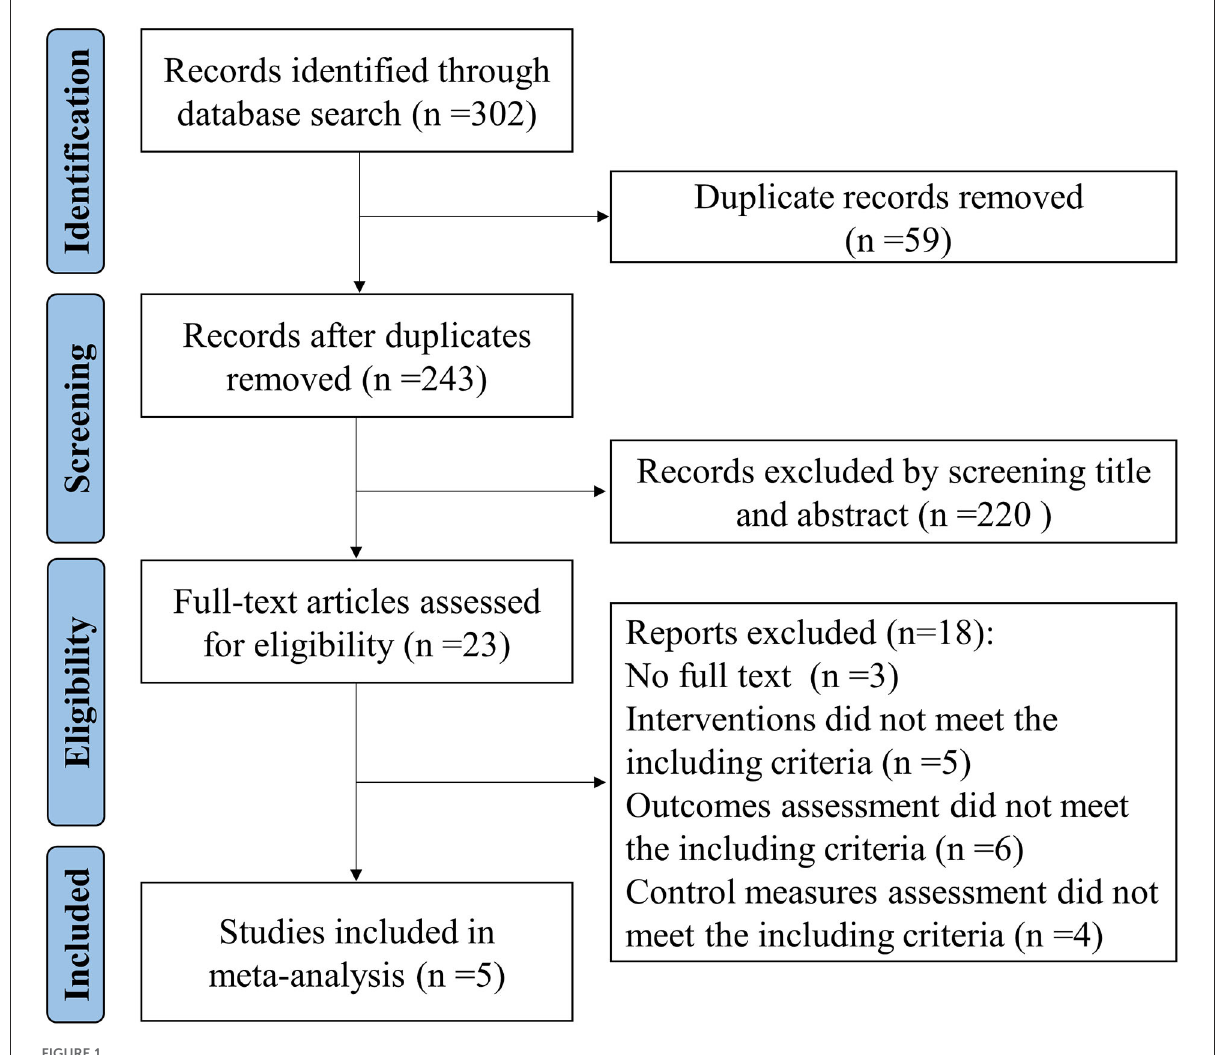
FIGURE1 Flow chart of the study selection